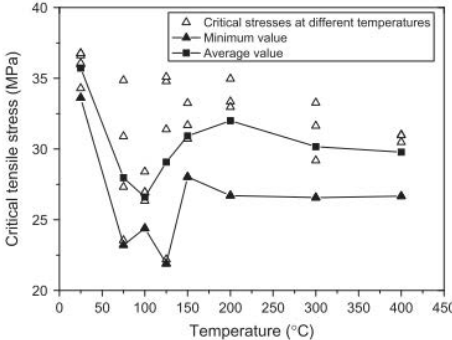
Fig. 5 AN SLS glass: Temperature dependence of critical tensile stress (Wang et al.